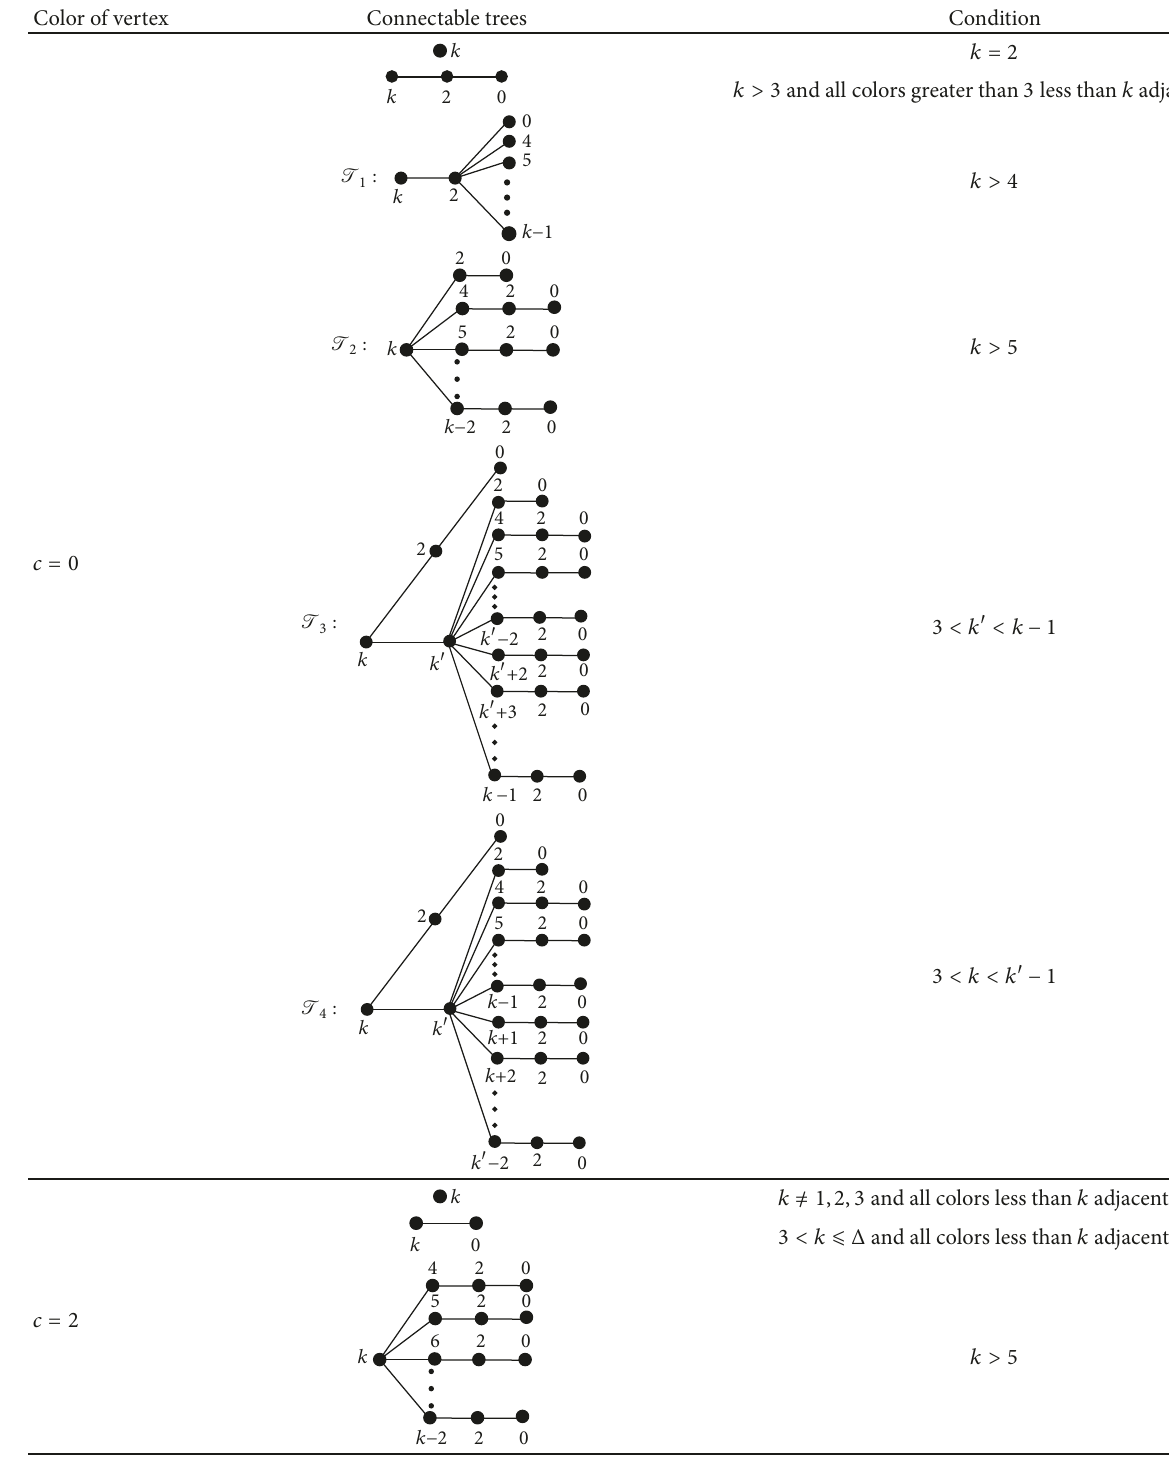
Table 1: Trees connectable to a vertex 𝑢 colored 𝑐 in a two-hole tree with 1 and 3 as holes. Color of vertex Connectable trees Condition k 𝑘 = 2 2 0k 𝑘 > 3 and all colors greater than 3 less than 𝑘 adjacent to 𝑐